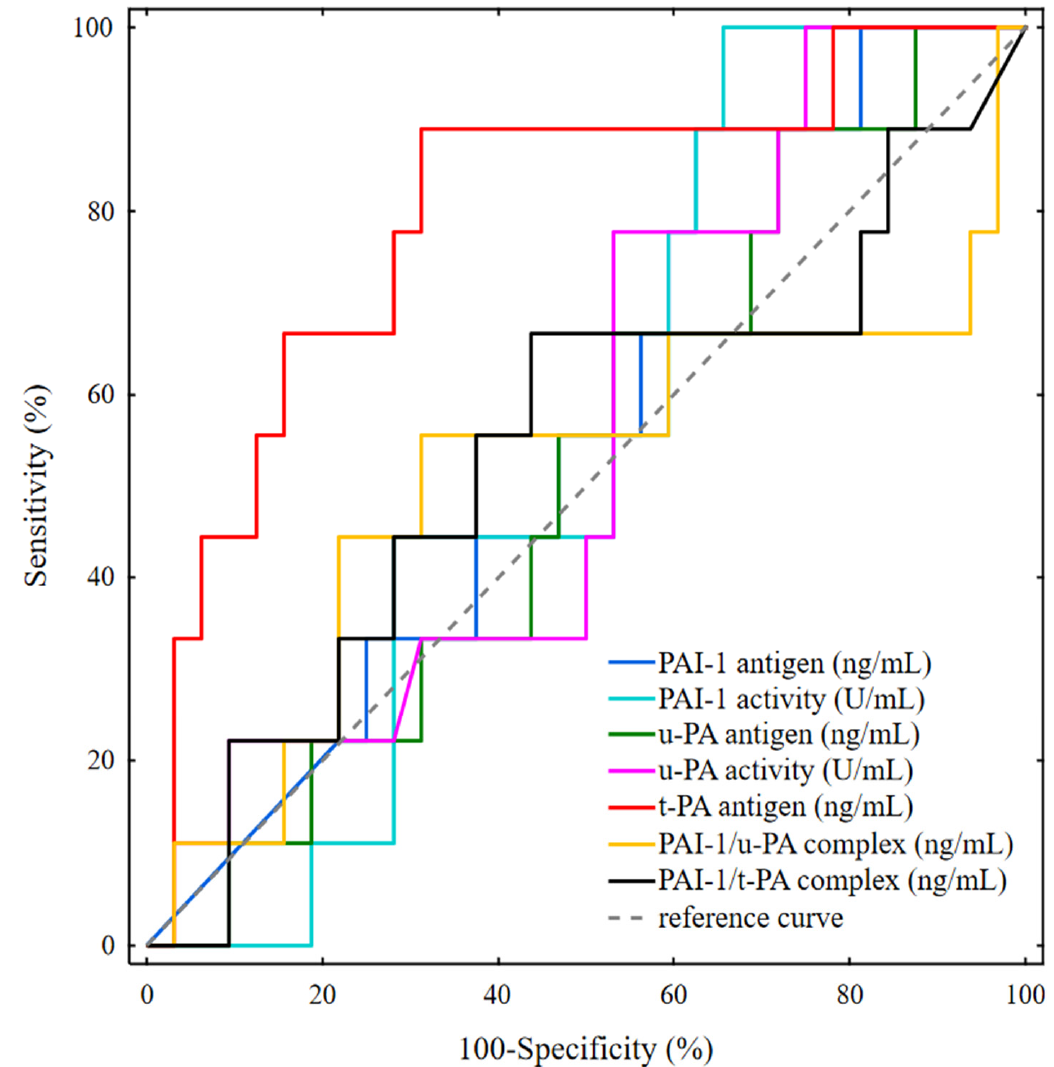
Figure 1. ROC curve analysis of the investigated fibrinolytic biomarkers.